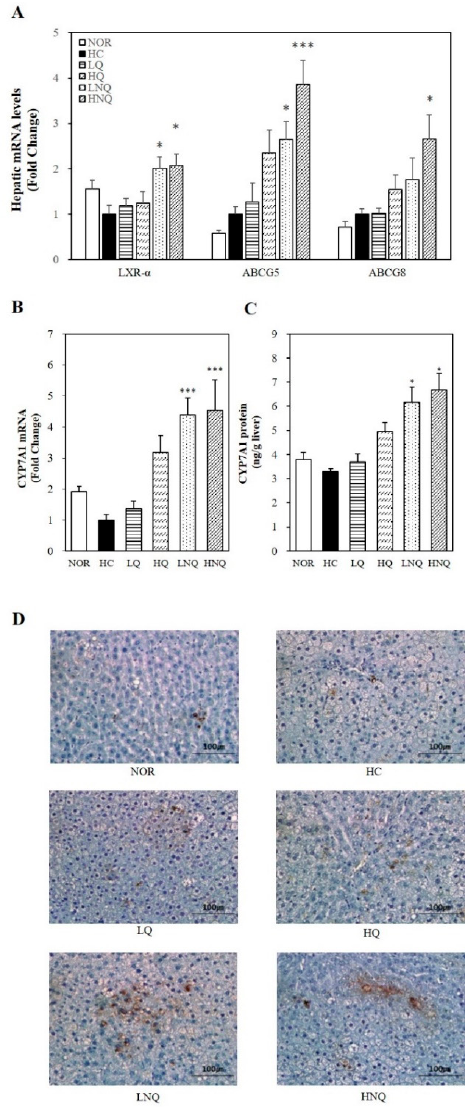
Figure 4. Influence of quercetin nanoemulsion on hepatic gene expression related to cholesterol efflux. mRNA levels of LXR α , ABCG5 and ABCG8 ( A ) and CYP7A1 ( B ) were measured by real-time qPCR and normalized to β -actin. The results were expressed as the fold change compared to HC. CYP7A1 enzyme activity was measured by a rat CYP7A1 ELISA kit and normalized to their relative microsomal protein contents ( C ). Immunohistochemistry staining for CYP7A1was performed using a diaminobenzidine-based staining technique ( D ). Values are expressed as means ± SEM ( n = 8). * p < 0.05, *** p < 0.001 versus HC group. CYP7A1, Cholesterol 7 α -hydroxylase. NOR: normal chow diet, HC: high cholesterol diet containing 1% cholesterol and 0.5% cholic acid, LQ: HC containing 0.05% quercetin, HQ: HC containing 0.1% quercetin, LNQ: HC containing 0.05% quercetin nanoemulsion, HNQ: HC containing 0.1% quercetin